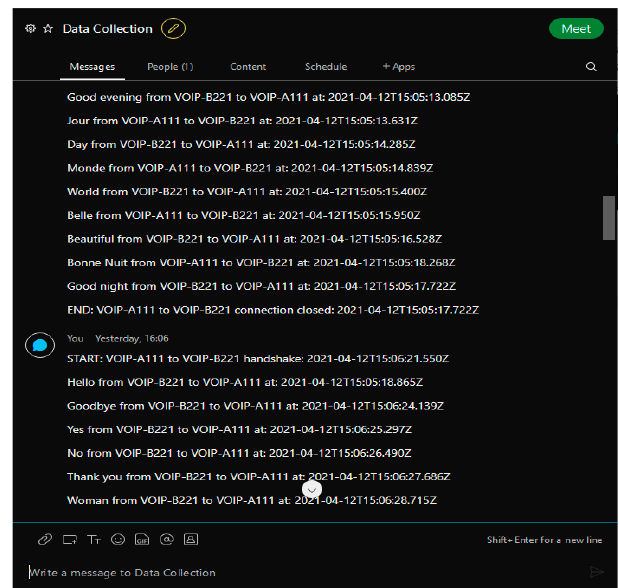
Figure 8. Cisco Webex data collection room.